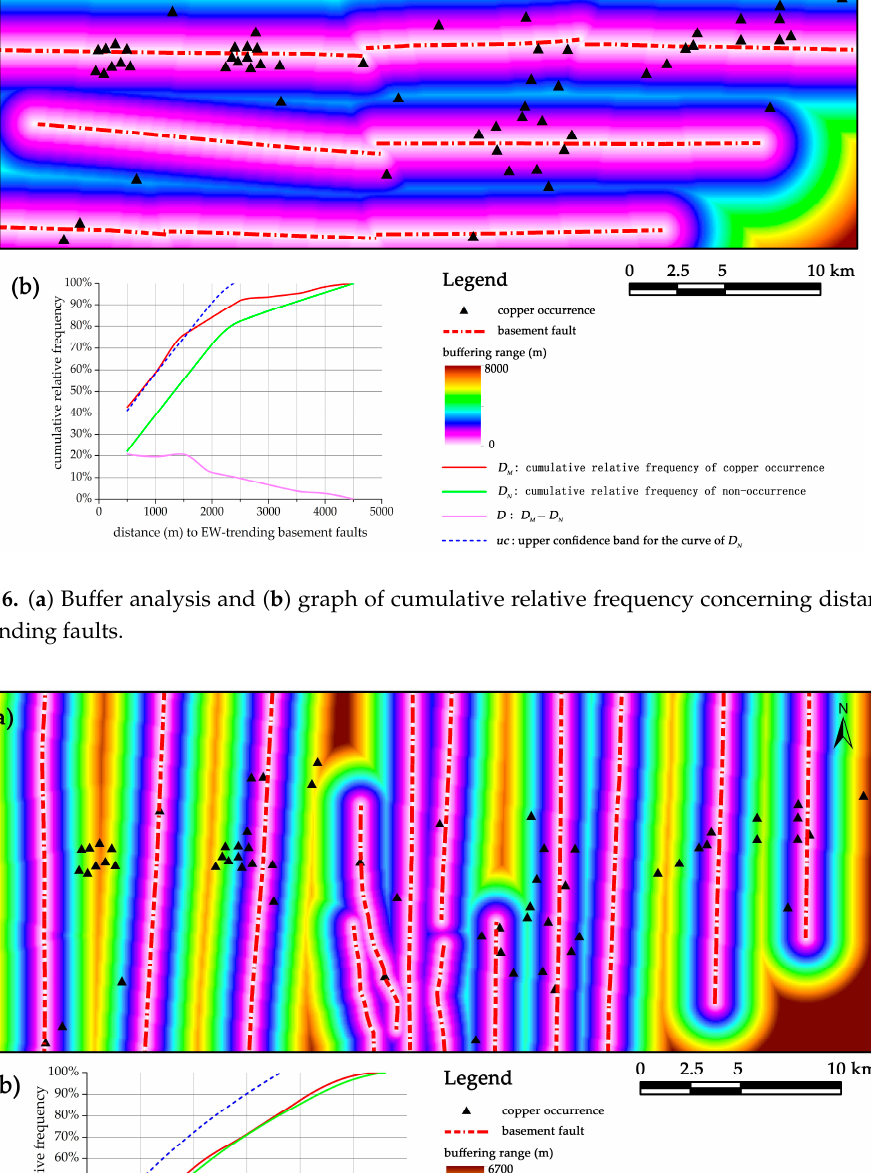
Figure 7. ( a ) Buffer analysis and ( b ) graph of cumulative relative frequency concerning distance to NS-trending faults.